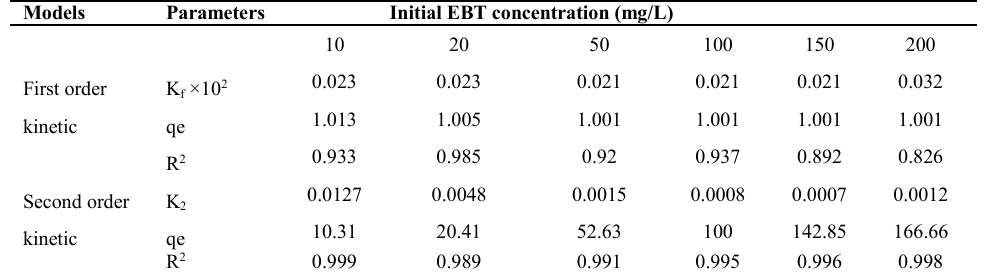
Table 2: Kinetic parameters of EBT adsorption onto ATPO-NPs (adsorbent dose 0.05 g/L and initial concentration 10–200 mg/L) Models